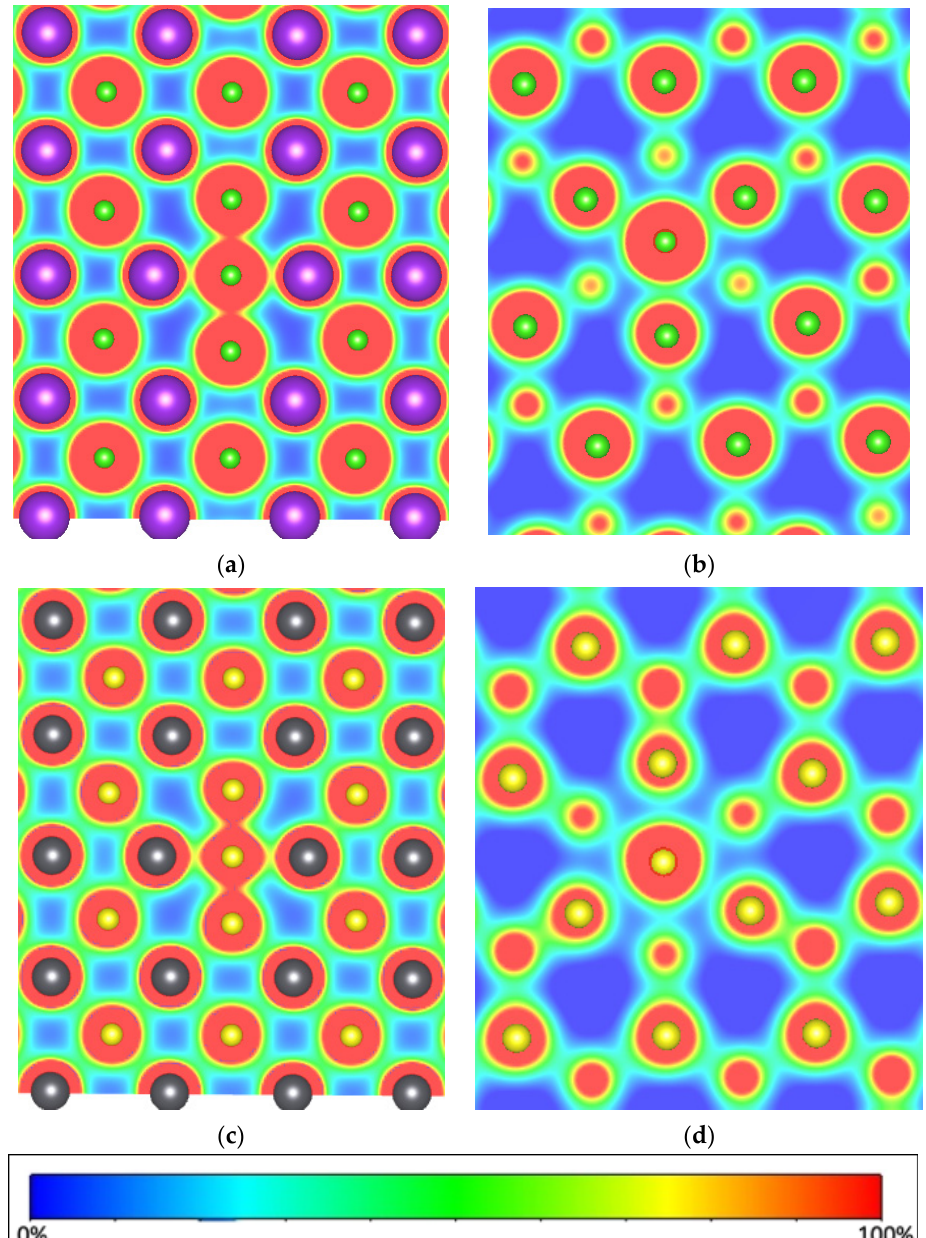
Figure 8. Charge density of ( a ) Cl base, ( b ) body-interstitial in KCl, ( c ) S base and ( d ) body-interstitial in PbS. Green, purple, black, and yellow atoms represent chlorine, potassium, lead, and sulfur atoms,